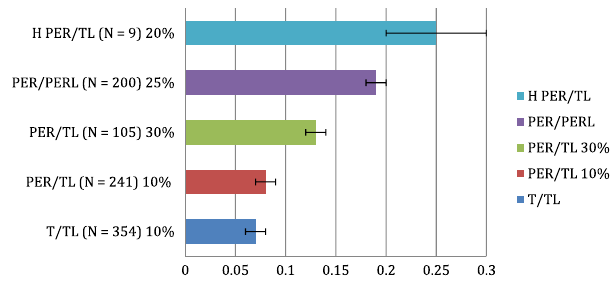
FIG. 6. Calculus-based BEMA normalized gain by laboratory and teaching style. The data are listed by laboratory or teaching style ( N ¼ number of students ) percentage total grade allotted to laboratories plus recitation . Lab styles are labeled by traditional (T), Real Time Physics (RT), combination RT and T (RT-T), developed at the University of Illinois (IL), and locally written PER-informed (PER). The lecture teaching styles are labeled by traditional lecture (TL), PER-informed lecture (PERL), and inquiry-based instruction (INQ). Honors sections are labeled with an